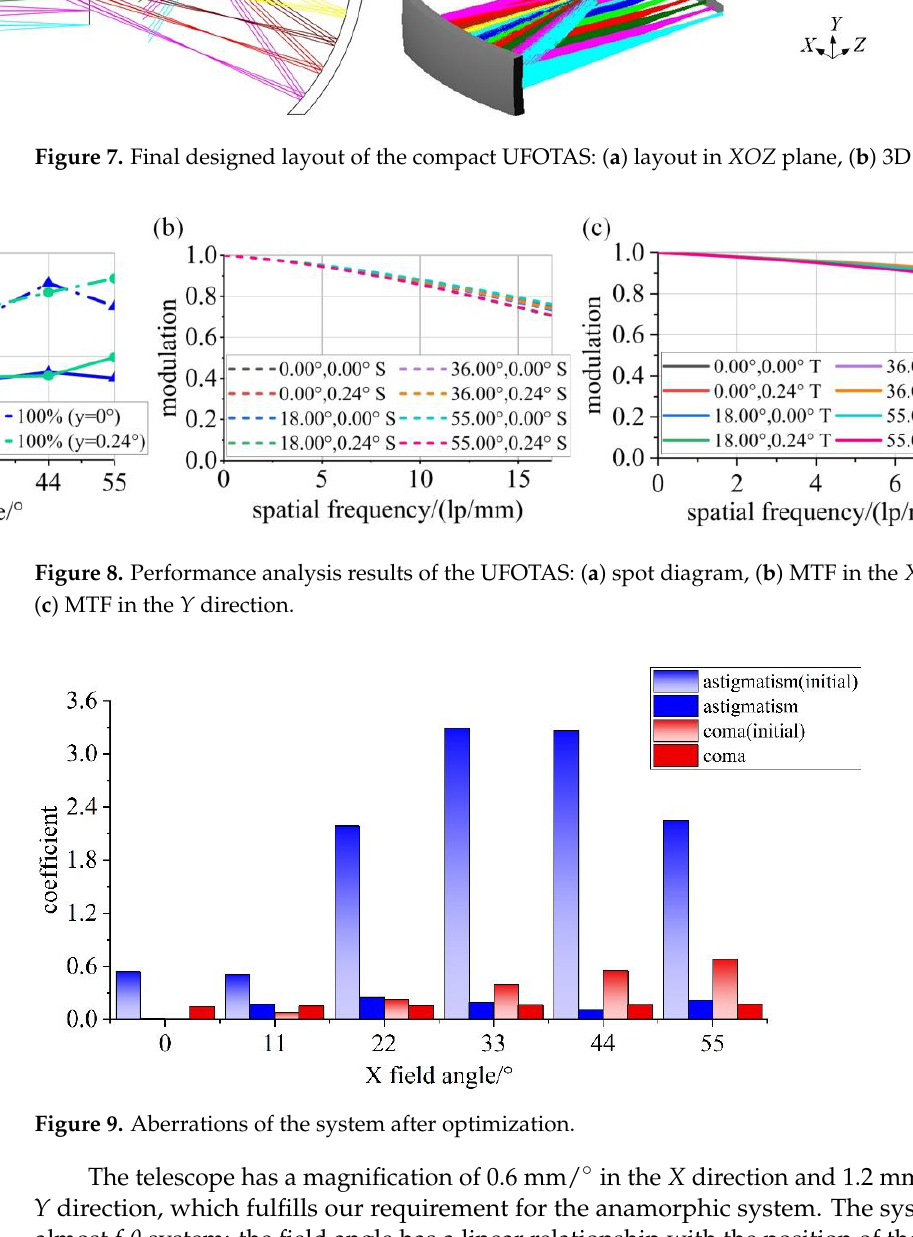
Figure 9. Aberrations of the system after optimization.